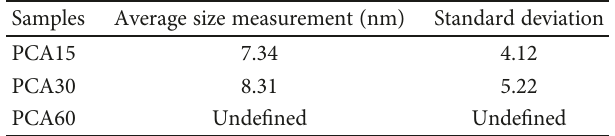
Table 1: Measured average nanoparticle